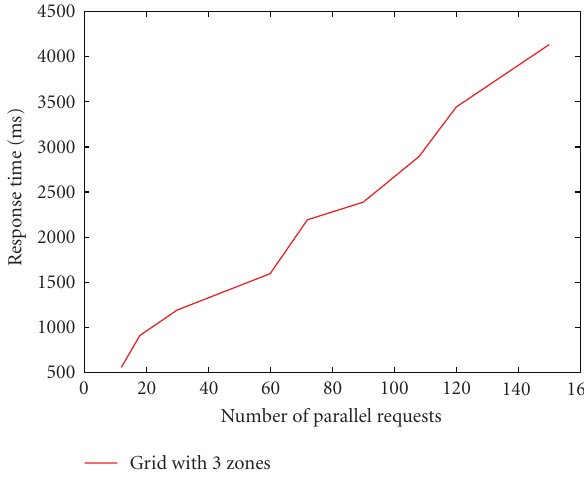
Figure 8: Response time (ms) for fetching patient history in a grid of size 20.